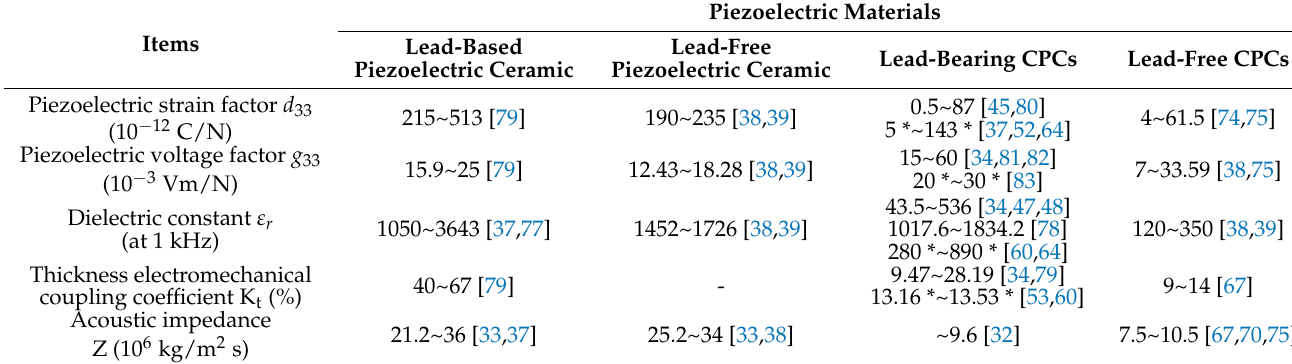
Table 2. Piezoelectric properties of piezoelectric materials.